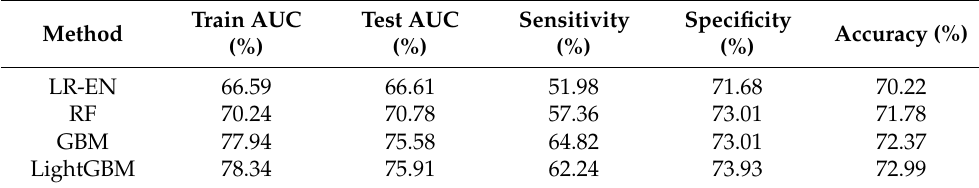
Table 3. Performance metrics for machine learning